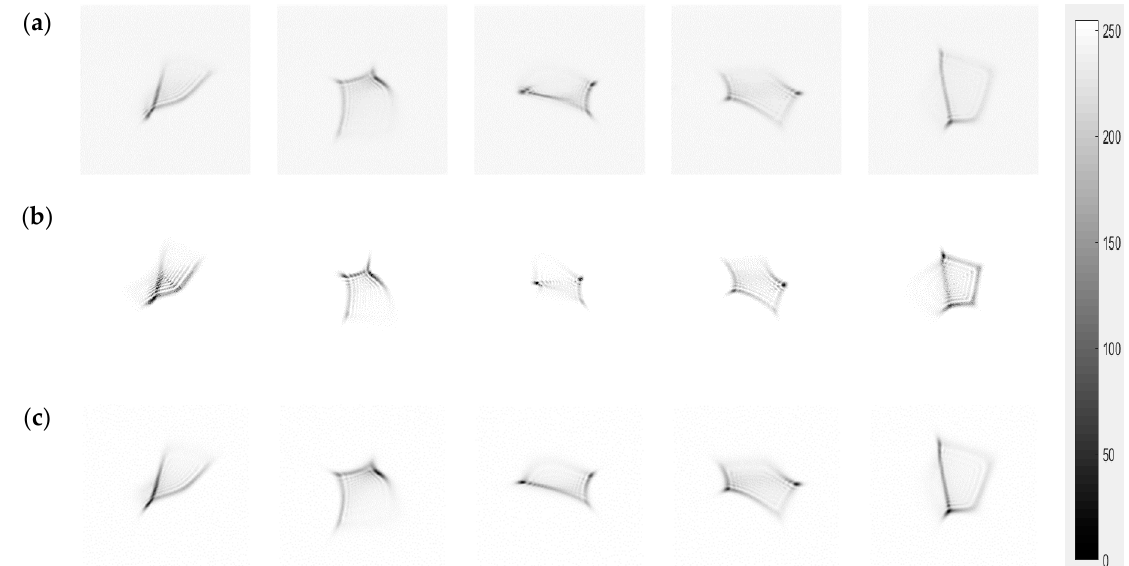
Figure 7. Experimental diagram of the physical deep learning wave-front sensor. C = collimator; A = aperture; P = polarizer; BS = beam splitter; LCSLM = liquid crystal spatial light modulator; and L = lens; CCD = charge-coupled device.